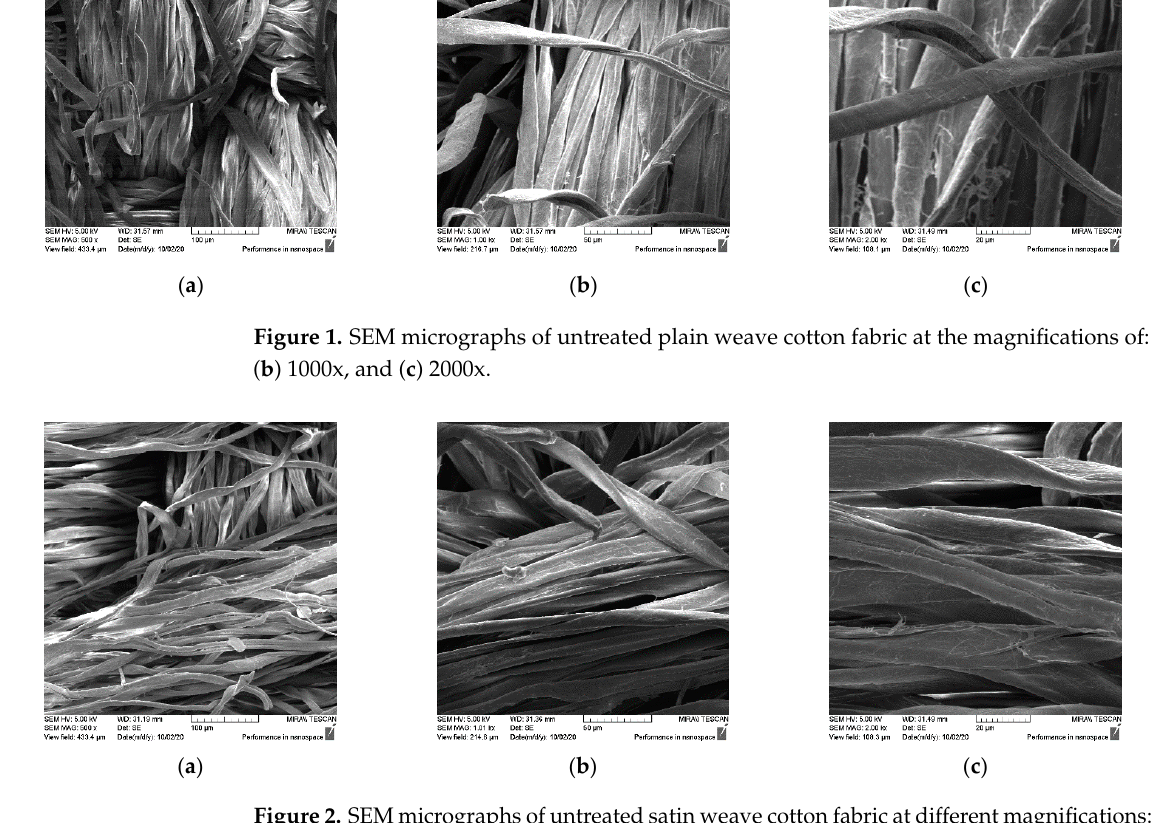
( f ) Figure 3. SEM micrographs of plain weave fabric samples treated with Bath I before (C_P_ApI) and after washing (C_P_ApI_w) at different magnifications: ( a , d ) 500x, ( b , e ) 2000x, and ( c , f ) 5000x.